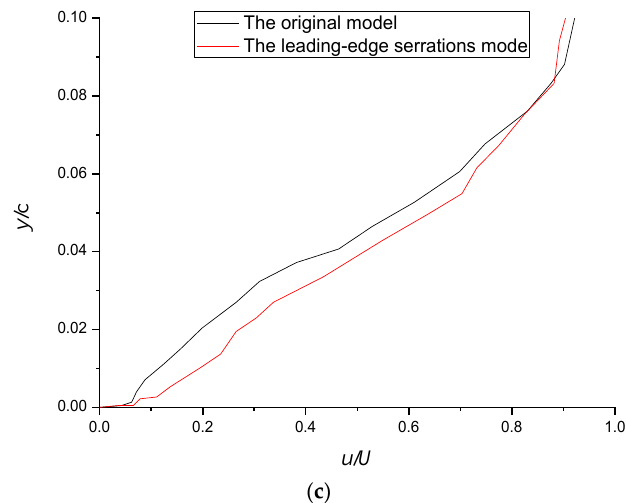
Figure 13. The boundary layer velocity distribution of the three points. ( a ) P oint A’; ( b ) Point B’; ( c ) P oint